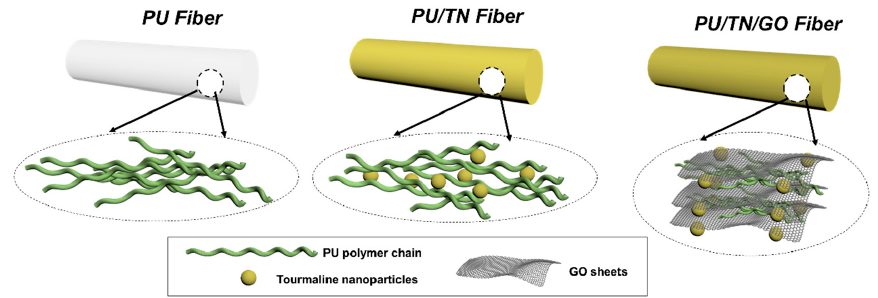
Figure 1. Schematic diagram of the PU and its nanocomposite fibers.